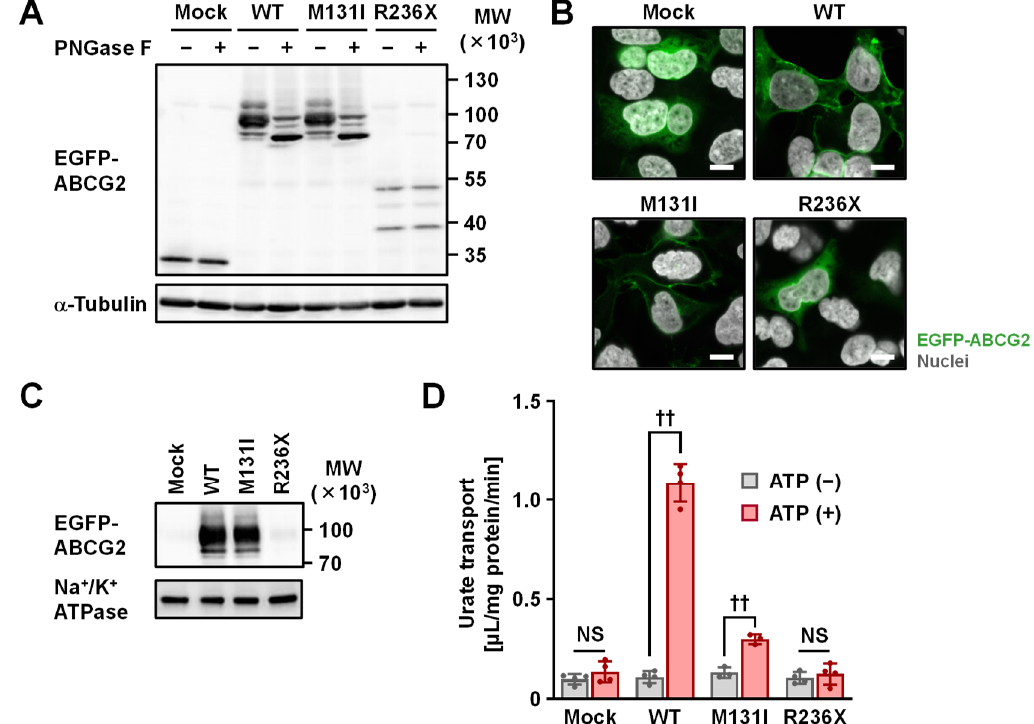
Figure 2. Functional characterization of disease-associated ABCG2 mutations. ( A ) Immunoblot of whole cell lysate samples. α-Tubulin used as the loading control. WT, wild-type. ( B ) Confocal microscopy of intracellular localization. Nuclei were stained with TO-PRO-3 iodide (gray). Bars, 10 µ m. ( C ) Immunoblot of plasma membrane vesicles. Na + /K + ATPase as the loading control. ( D ) Urate transport activity. The incubation condition was 37 °C for 10 min in the presence of 20 μ M radiolabeled urate. Data are expressed as the mean ± SD. n = 3–4. ††, P < 0.01; NS, not significantly different between groups (two-sided t -test).